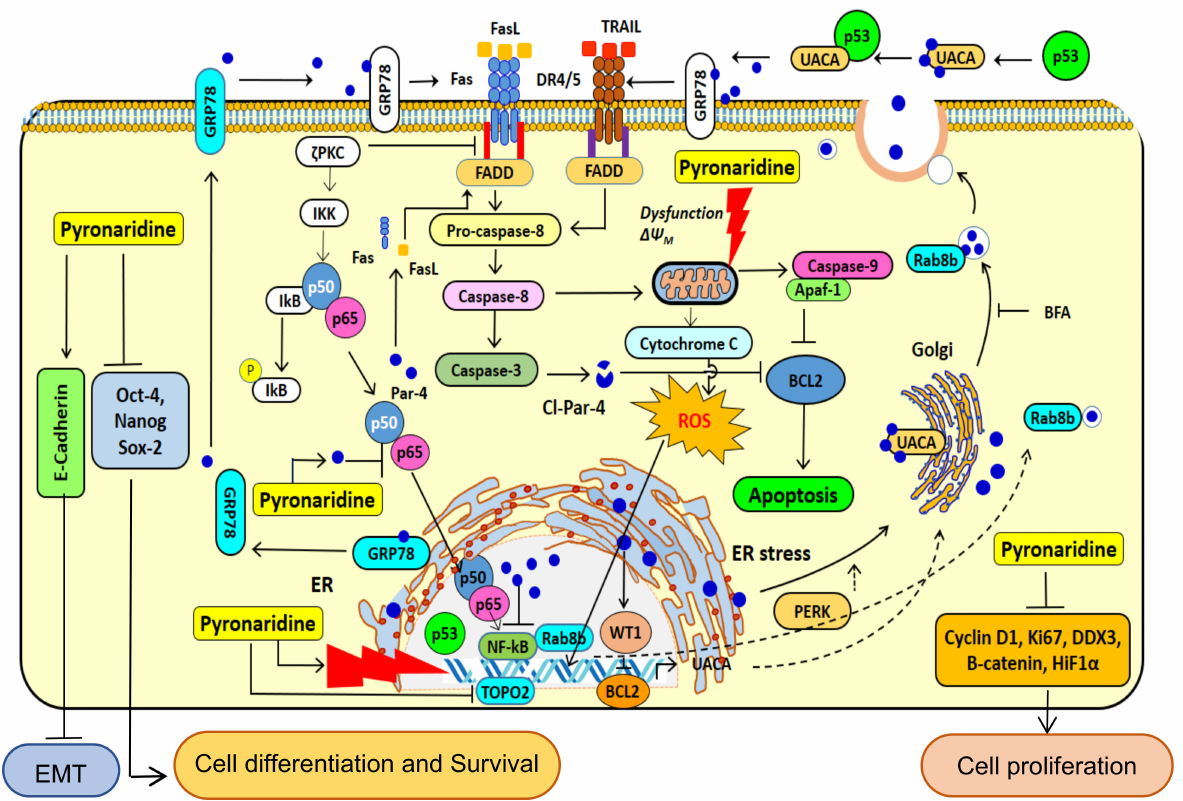
Figure 10. Proposed cellular mechanism of action of PYR. The illustration depicts the proposed mechanism of PYR in cancer cells, modulating cellular pathways to induce growth inhibition and apoptosis in glioma cells. PYR is an acridine derivative, which intercalates DNA and impairs DNA repair pathways. PYR-induced DNA damage promotes activation of p53-mediated cell cycle arrest. In addition, PYR inhibits Topoisomerase II and induces mitochondrial depolarization thereby initiating caspase 3 and 9 mediated intrinsic apoptosis pathways. PYR induces tumor suppressor protein— Par-4 through inhibition of nuclear localization of p65, NF- κ B, BCl-2 and activating pro-apoptotic pathway proteins BAX. PYR increases oxidative stress after DNA damage and decreases MMP. PYR upregulates the production of p53, capase3/9, Bax, and Cyto-C and downregulates the production of Bcl-2, promoting the release of Cyto-C, increasing caspase-3/7 activities, and potentiating apoptosis in glioma cells. Bax, Bcl-2-associated X protein; Bcl-2—B-cell lymphoma 2; Cyto C—cytochrome